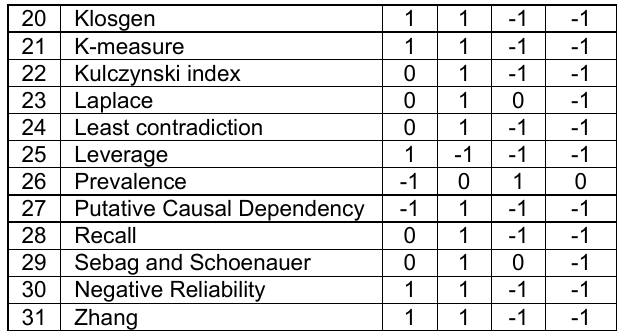
Table 1: The statistical implication data of the measures according to parameters 𝑛, 𝑛